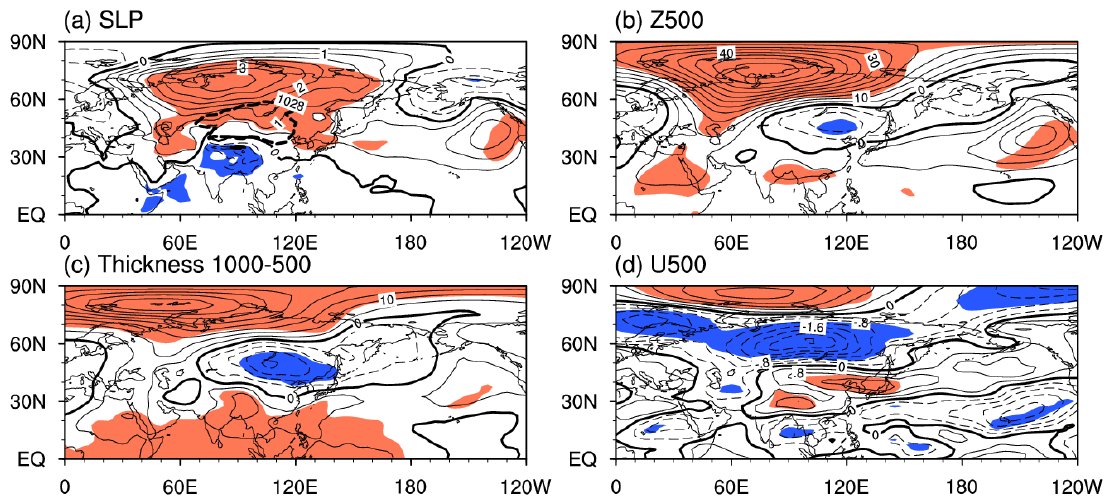
Figure 10. The ( a ) SLP (CI = 0.5 hPa), ( b ) Z500 (CI = 5 gpm), ( c ) Thickness 1000–500 hPa (CI = 5 gpm), and ( d ) U500 (CI = 0.4 m · s − 1 ) pattern regressed against the Arc-index during 1991–2015. Shaded values are significant, exceeding 95% confidence level based on Student’s t- test.